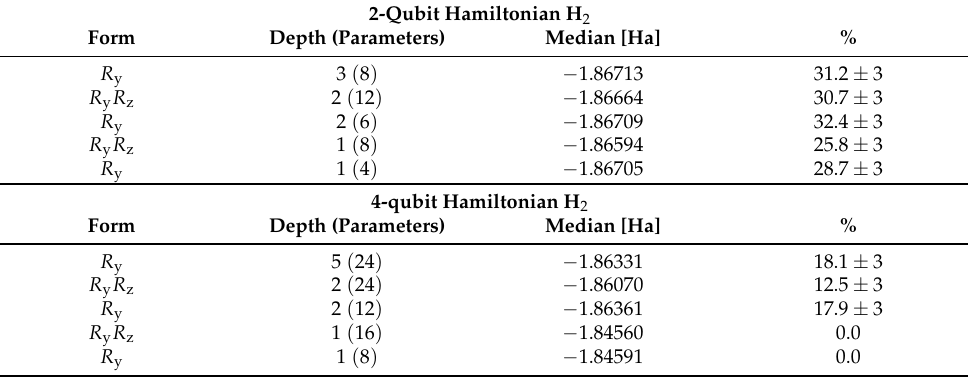
Table A4. A comparison of various settings of quantum circuits for 2-qubit and 4-qubit Hamiltonians of H 2 . The R y R z and R y variational forms accompanied by linear entanglement with different depths of circuit and numbers of parameters used. In the case of the 2-qubit Hamiltonian, we used an unrestricted maximum number of iterations of the SPSA optimizer, and in the case of 4-qubit Hamiltonian, the maxiter was set to 400. Columns labeled % represent the percentage of the runs that ended within chemical accuracy ( − 1.86712 ± 0.0015 Ha) of the optimum. The error margin of 3 percent was estimated based on the standard deviation of 1000 identically distributed trials. These data are the basis for Figure